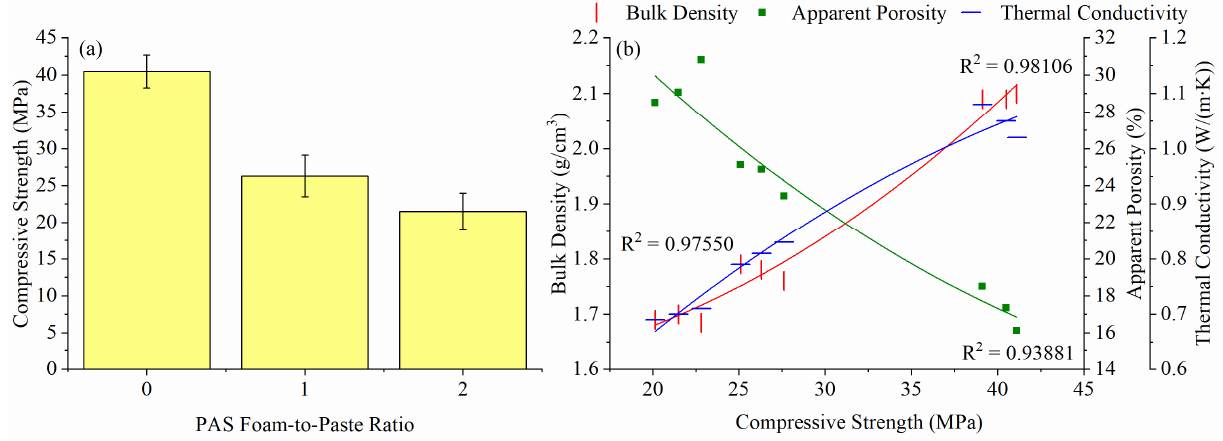
Figure 6. ( a ) Compressive strength and ( b ) correlation curve between compressive strength, bulk density, apparent porosity and thermal conductivity of G-0, G-1 and G-2.